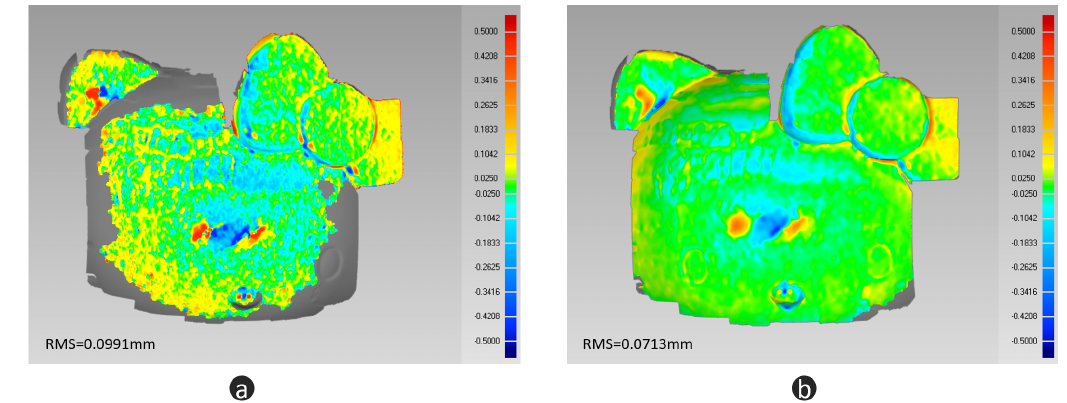
Figure 12. Accuracy evaluation. ( a ) comparison between FPP data and ground truth; ( b ) comparison between the data measured with proposed method and ground truth.